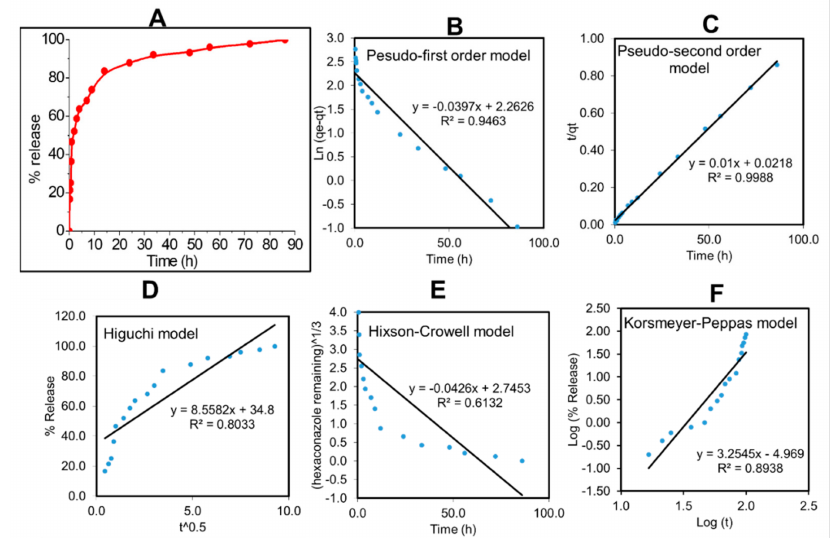
Figure 6. Cumulative release profiles of the ( A ) CHEN5 at pH 5.5 and ( B–F ) their fitting of the data using five di ff erent mathematical models at pH